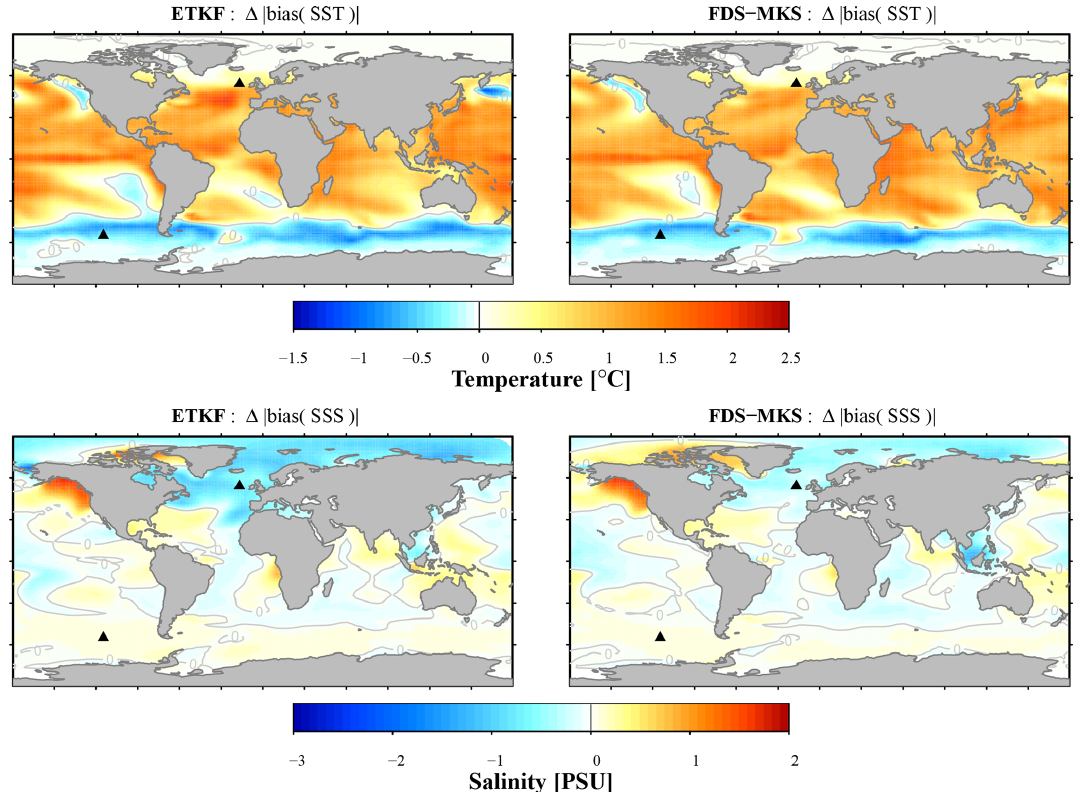
Figure 5. CESM experiment. Absolute bias reduction for SST and SSS as a result of a new integration with the parameters estimated with the ETKF and the FDS-MKS. The statistics are the absolute bias between the background and the truth minus the absolute bias between the analysis and the truth. Thus, positive values are a net bias reduction. Isolines at value 0 shown in grey. The two triangles indicate the locations in the North Atlantic and South Pacific connected with Figs. 4 and